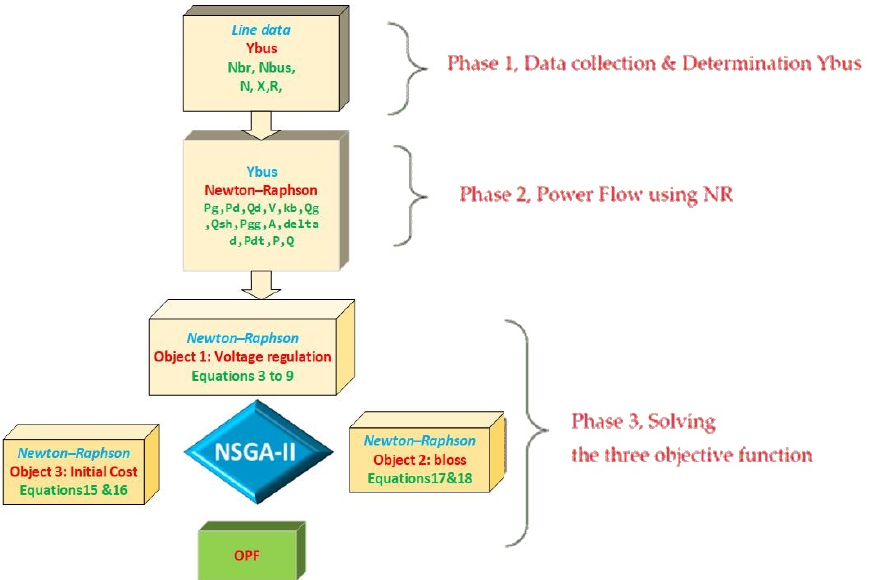
Figure 1. Optimal Power Flow approach using NSGA-II.